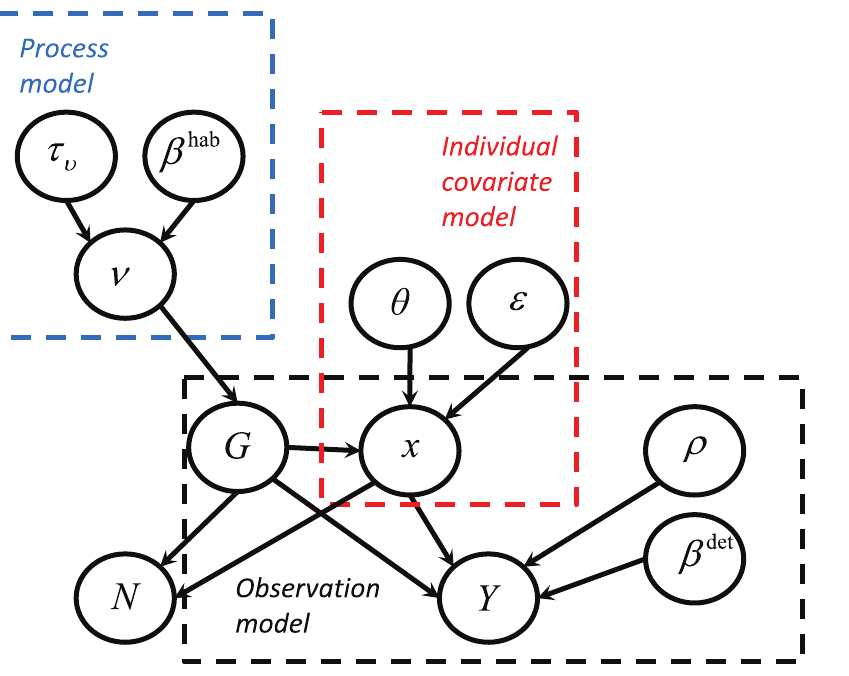
Figure 1. Directed, acyclic graph (DAG) of the (areal) hierarchical model for distance data. Individual nodes indicate a parameter or vector of parameters, and arrows represent conditional dependence. Notation is defined in Table 1.